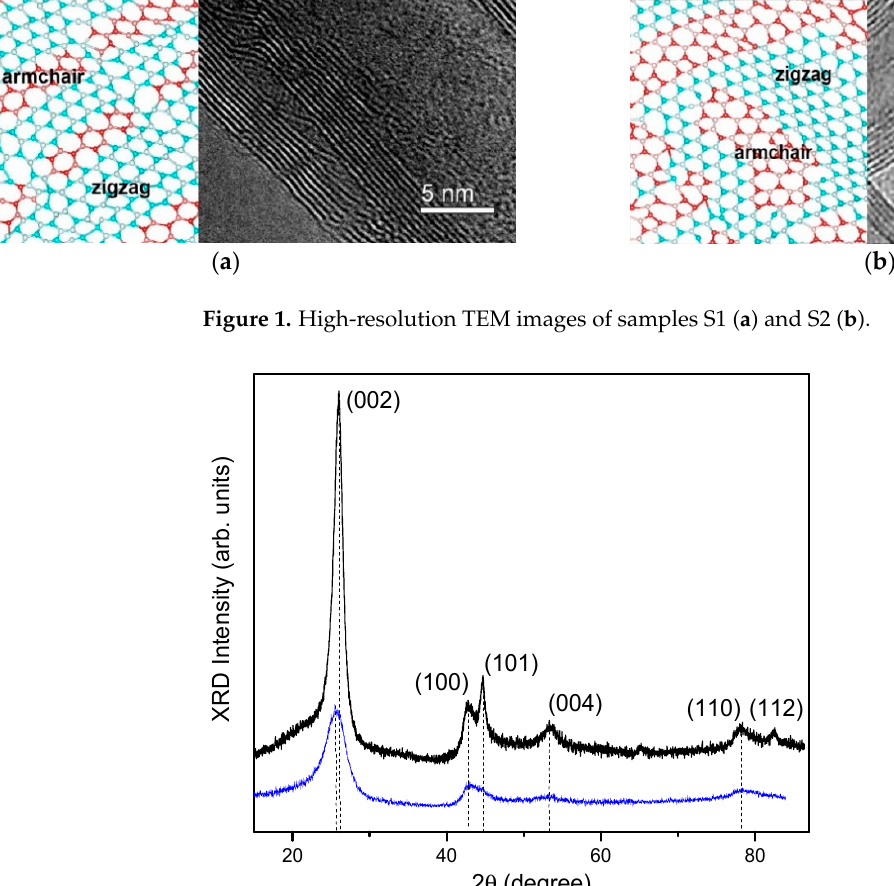
Figure 1. High-resolution TEM images of samples S1 ( а ) and S2 ( b ).